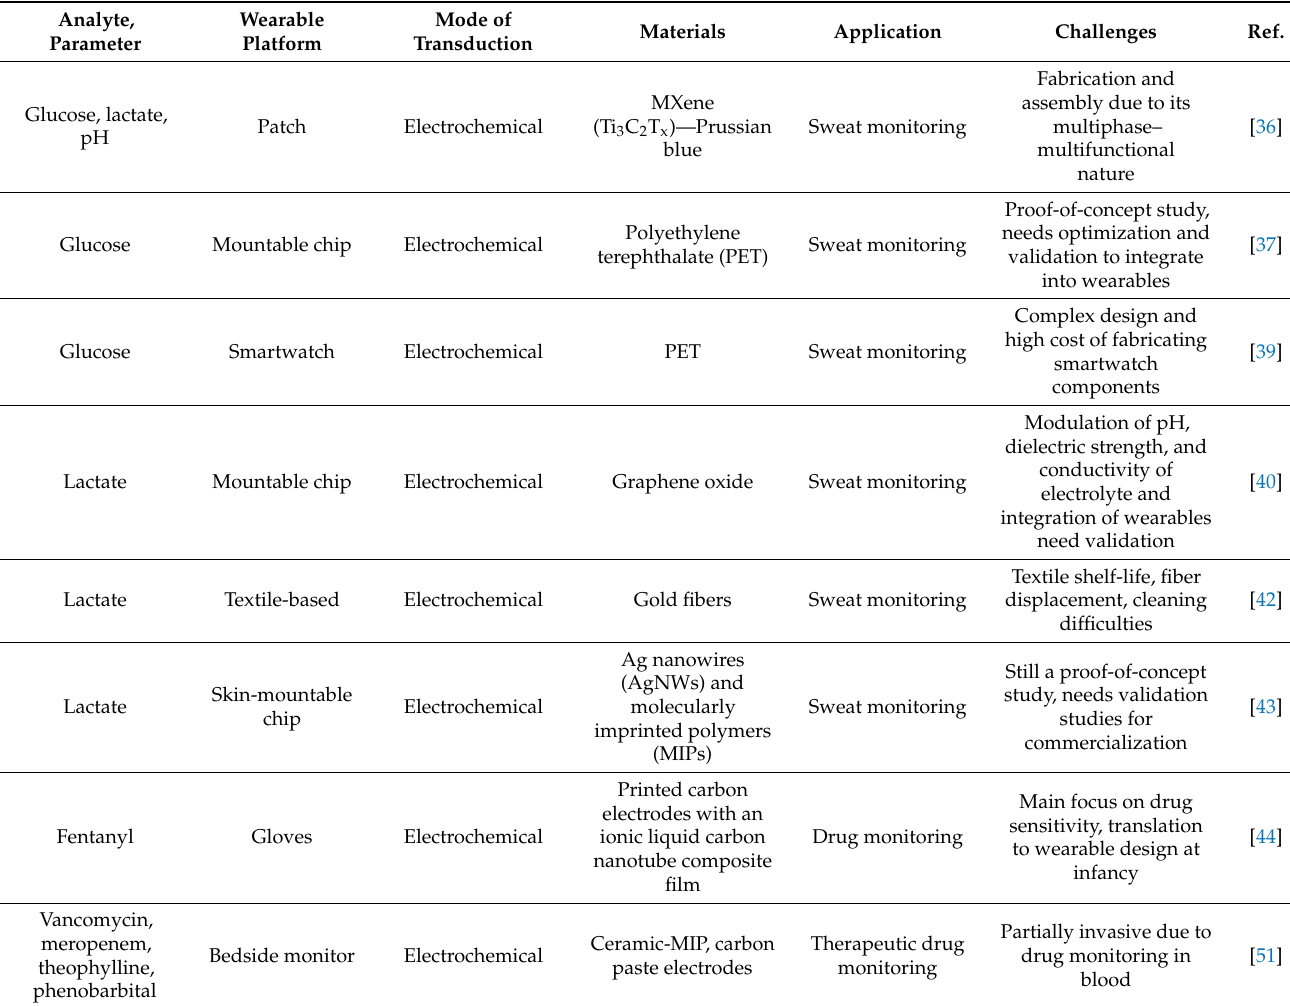
Figure 8. PPG-based optical wearables for heartbeat monitoring. ( A ) Schematic illustration of the sensor assembly for PPG measurement and the corresponding electrical components of the PPG signals. ( B) Design of the ring at different views with a strapdown of the electrical module (right bottom); the top right shows the different parameters considered for superior ergonomics. Abbr.: low-energy Bluetooth (BLE), power-management unit (PMU), microcontroller (MCU), D (diameter), W (width), t (thickness), f (internal filleting radius), b (sensor position). Image reproduced with permission from [113], https://creativecommons.org/licenses/by/4.0/, accessed on 26 November 2021. Table 1. Selected examples of recently developed wearable